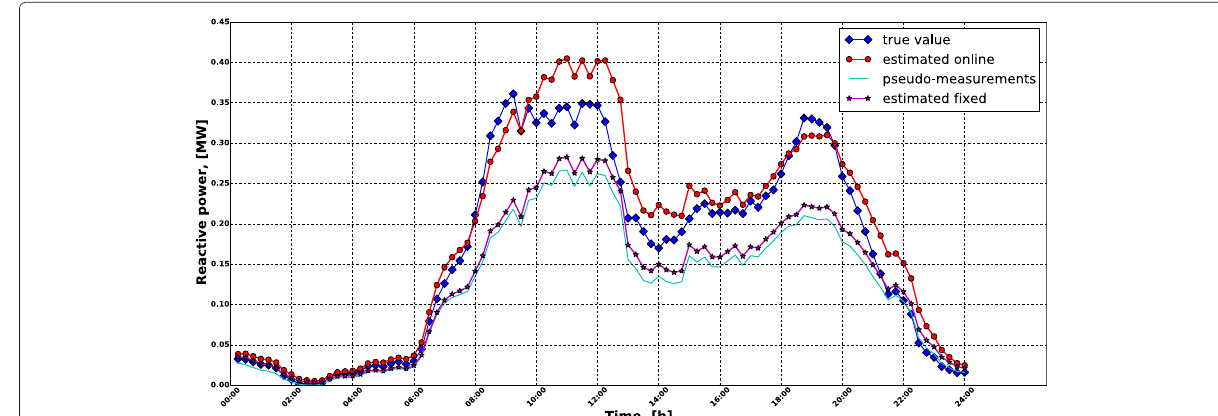
Fig. 5 Reactive power estimation using the NLO with the proposed online learning technique at node